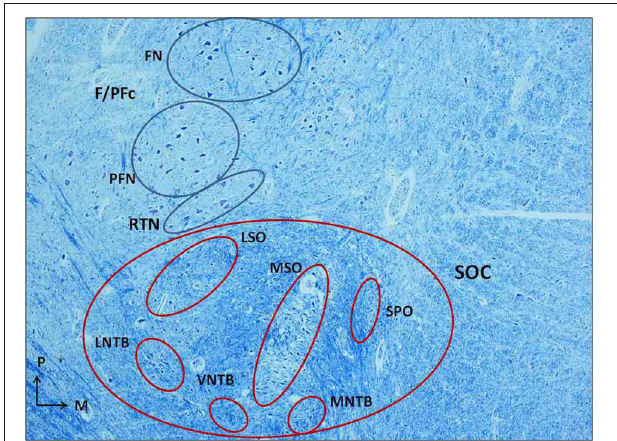
FIGURE 1 | Histological section of human caudal pons (3 month-old control) showing the localization of the superior olivary complex (SOC), anterior and slightly medial to the facial/parafacialcomplex (F/PFc), and the adjacent retrotrapezoid nucleus (RTN), and its cytoarchitectural organization. Klüver–Barrera stain. Magnification: 4 × . FN, facial nucleus; F/PFc, facial/parafacial complex; LNTB, lateral nucleus of the trapezoid body; LSO, lateral superior olivary nucleus; MNTB, medial nucleus of the trapezoid body; MSO, medial superior olivary nucleus; PFN, parafacial nucleus; RTN, retrotrapezoid nucleus; SOC, superior olivary complex; SPO, superior paraolivary nucleus; VNTB, ventral nucleus of the trapezoid body.